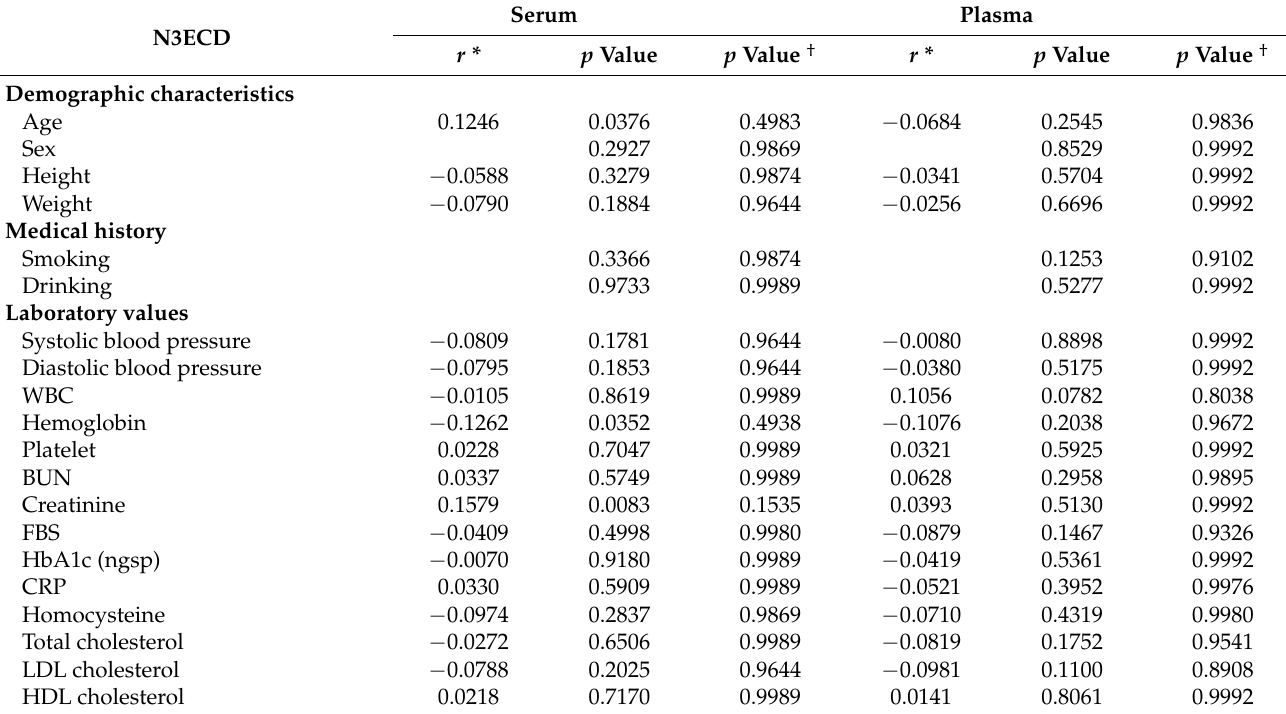
Figure 4. Correlations between serum N3ECD levels and laboratory values. Correlations of N3ECD with creatinine ( A ), and hemoglobin ( B ). Correlations of serum Jag-1 with systolic blood pressure ( C ), HbA1c ( D ), and triglyceride ( E ). Each symbol represents values from a single subject. The resulting Spearman’s correlation coefficient ( r ) and corresponding p value are reported. Table 2. Correlations between blood N3ECD levels and clinical